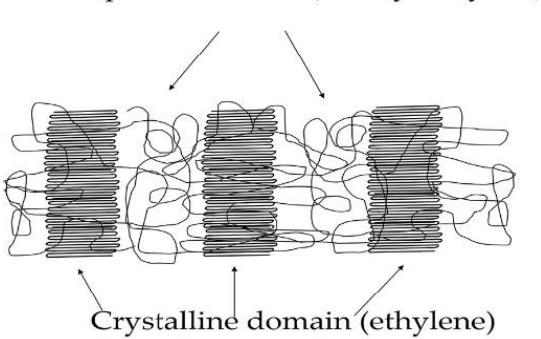
Figure 1. Scheme of the domains structure of the ethylene-co-n-butyl acrylate (EBA) copolymer.